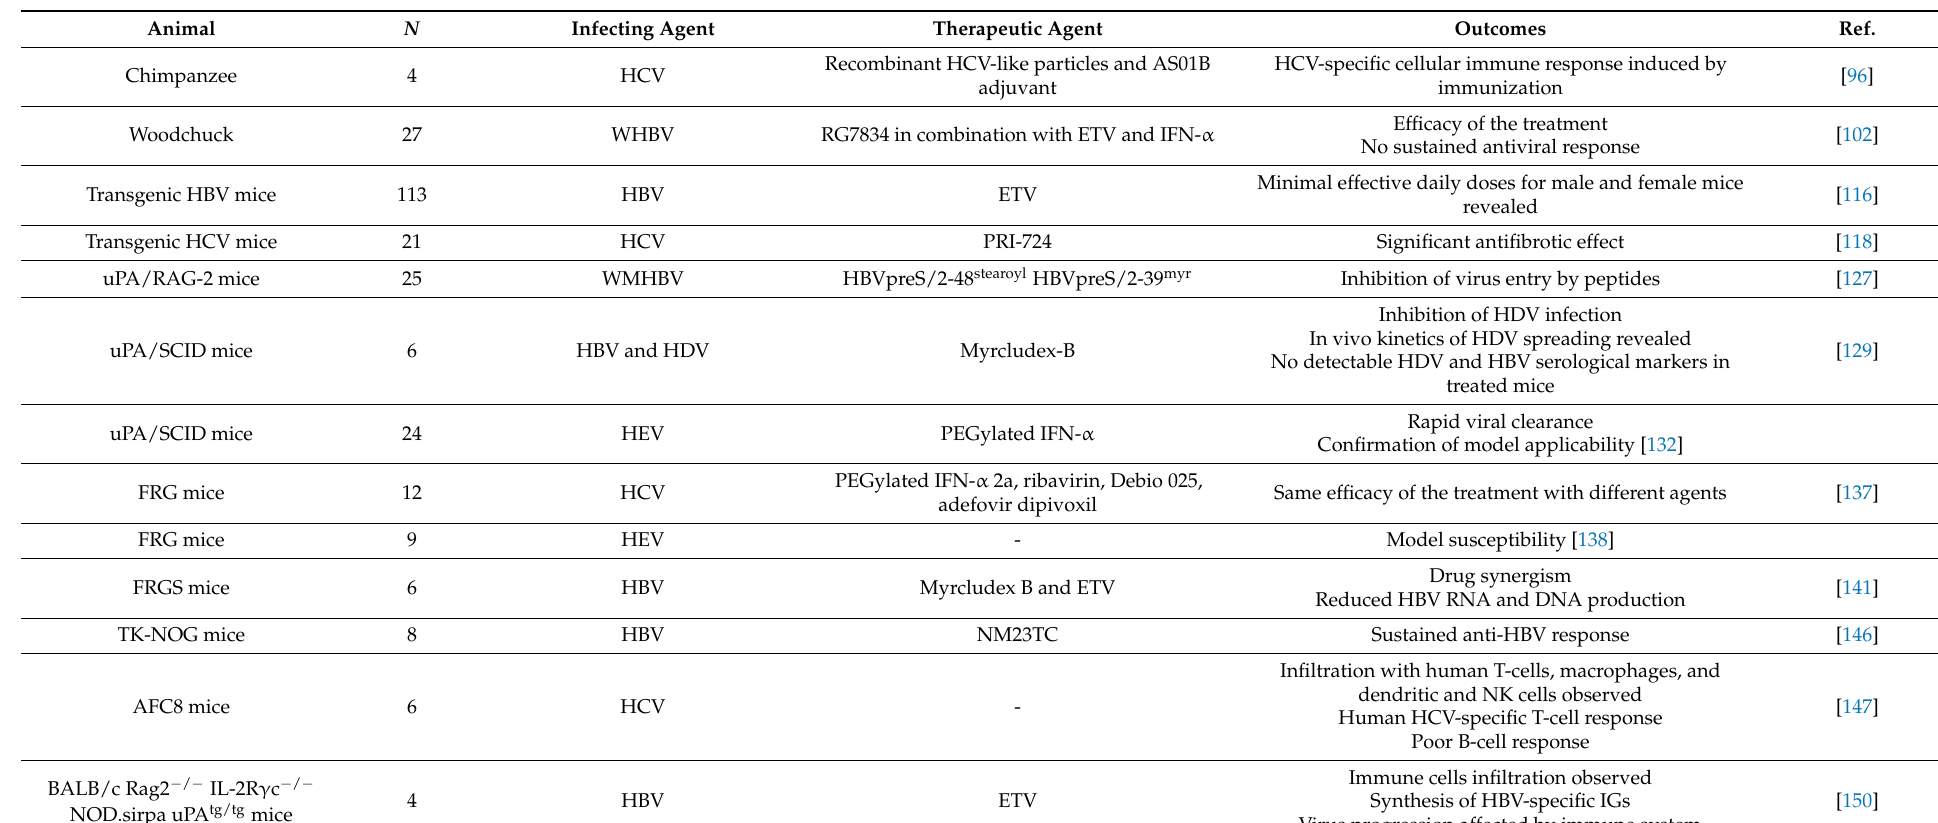
Table 2. Animal models are used to study hepatotropic